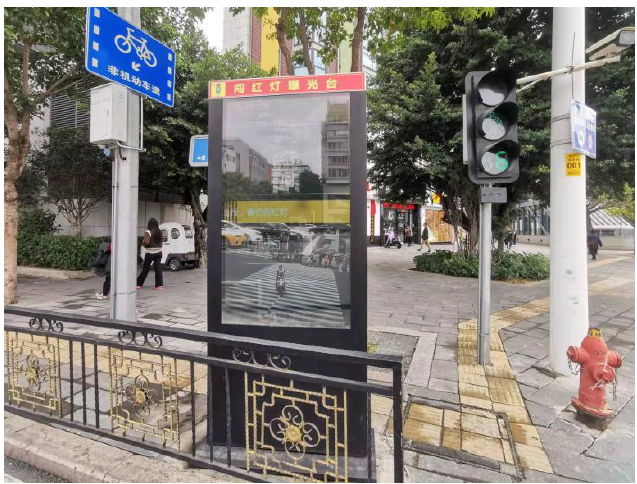
Figure 2. Part of the red-light monitoring system.